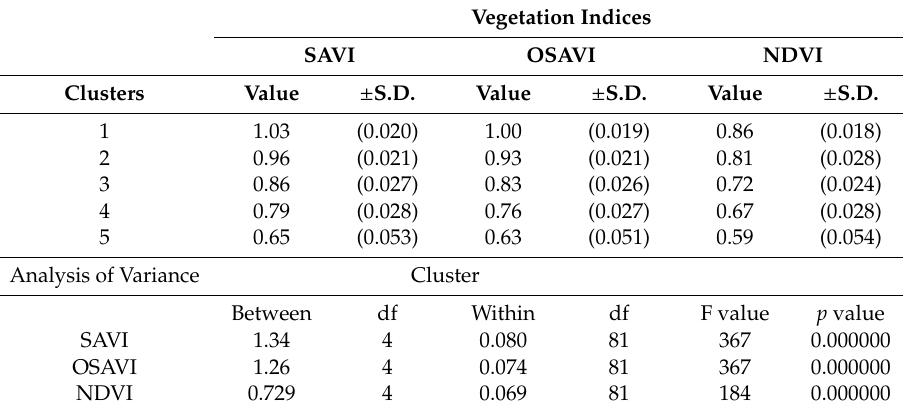
Table 3. Vegetation Indices (VIs) median values, standard deviations and analysis of variance of clusters identified by Ward’s cluster method. The median values are assumed as a measure of central tendency in case of not symmetrical data distribution.